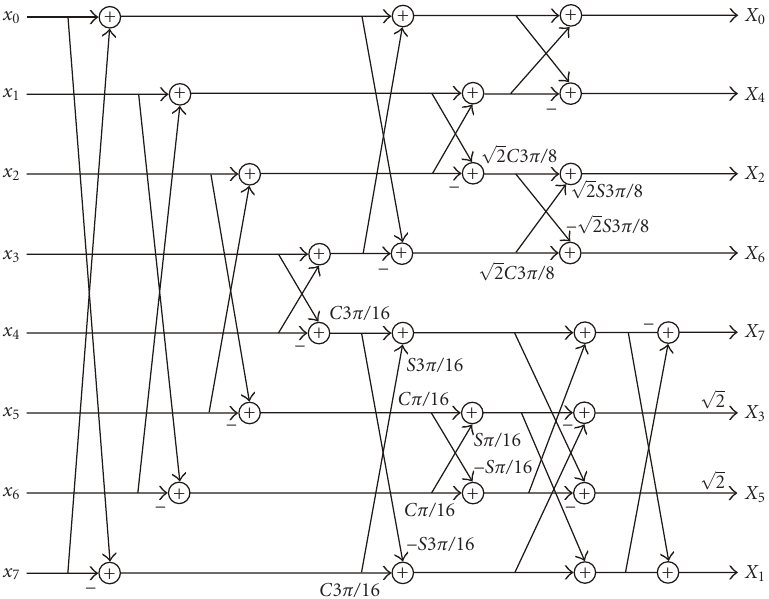
Figure 1: Signal flow graph of Loe ffl er’s factorization of the eight-point